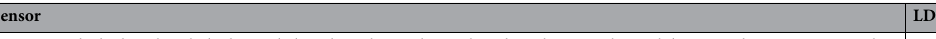
Sensor LDR (% RH) Response time (s)